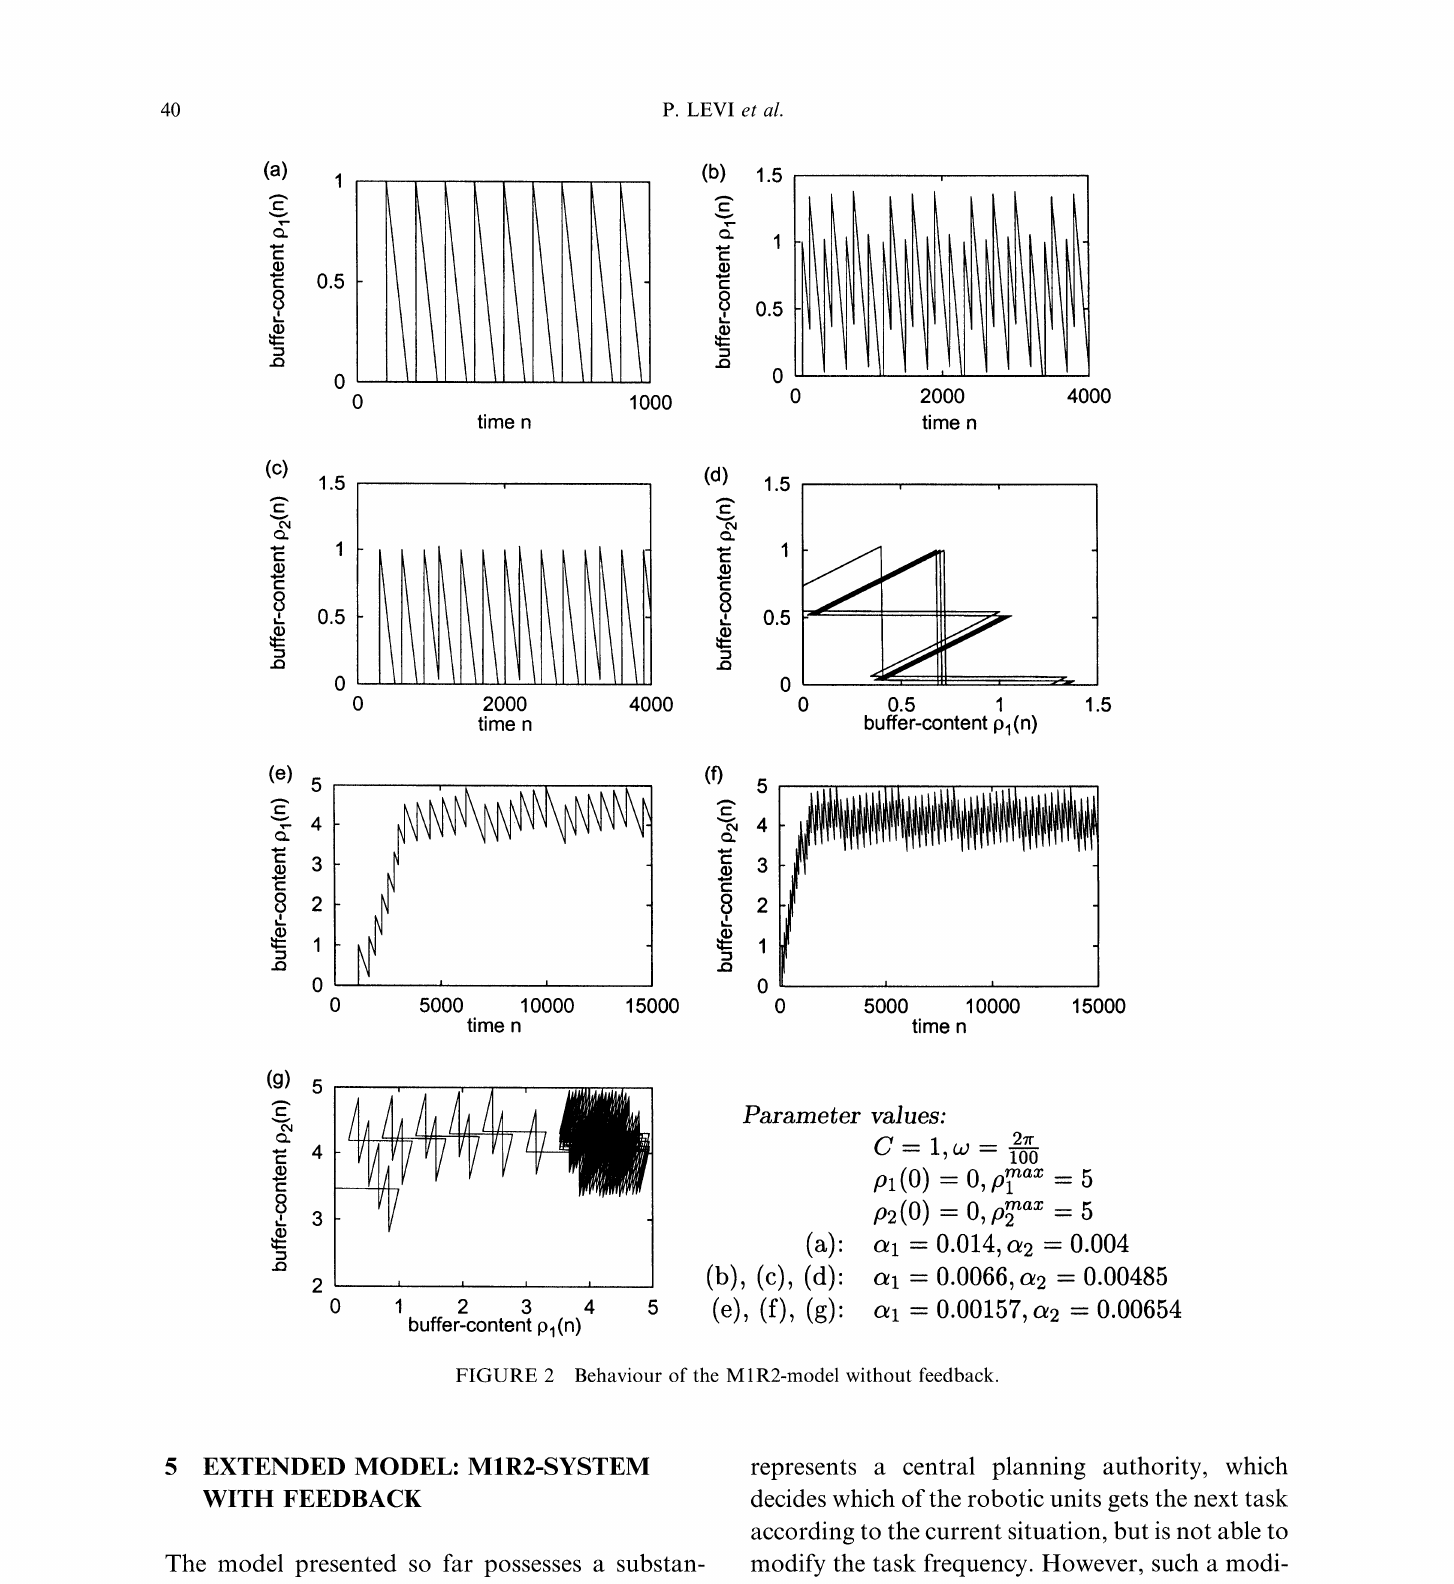
FIGURE 2 Behaviour of the M1R2-model without